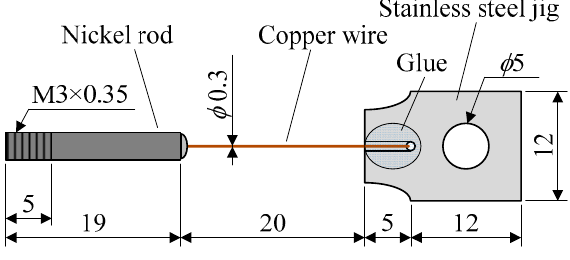
Figure 1. Shape and size of solder joint specimen.